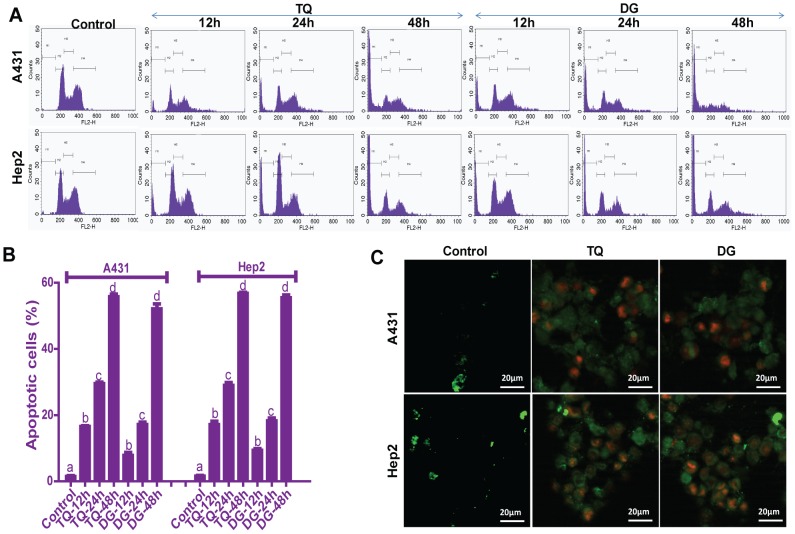
TQ- and DG- induce apoptosis in A431 and Hep2 cells.(A) Dose-dependent effects of TQ and DG detected by cell cycle–based apoptosis assay. Cells were treated with respective IC50 of TQ or DG for 48 hours, stained with PI and measured by flow cytometry. (B) Accumulation of sub-G1 cells plotted from the cell cycle–based apoptosis assay. Data are presented as means ± SEM from three independent experiments. Dissimilar superscripts (a, b, c, d) represent the significant differences among them (P<0.05). (C) After treating with IC50 of TQ or DG, cells were stained with Annexin V-FITC and PI and analysed by fluorescence microscopy. Three primary populations of cells: cells are viable and not undergoing apoptosis (Annexin V-FITC and PI negative), cells undergoing apoptosis (Annexin V-FITC positive and PI negative) and cells in end-stage apoptosis or already dead (Annexin V-FITC and PI positive).